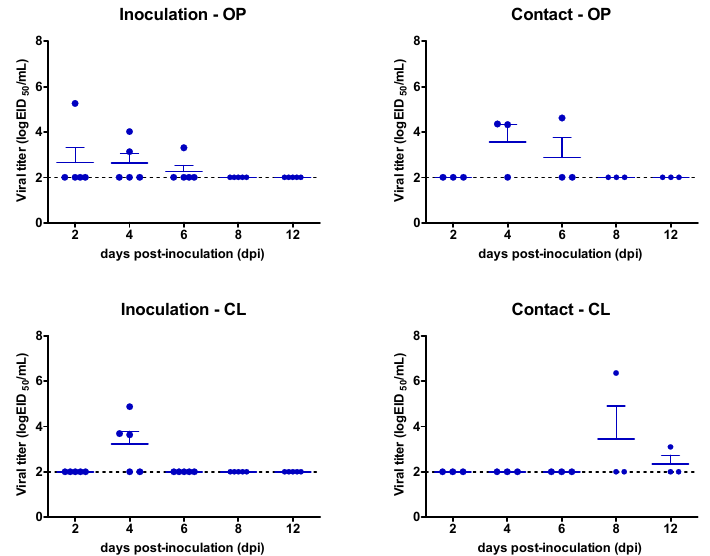
Figure 2. Viral shedding of domestic pigeons infected with genotype C1 of clade 2.3.4.4 H5N6 HPAIV. The detection limit was 10 2 EID 50 equivalent/mL (dotted line). OP, oropharynx; CL, cloaca.